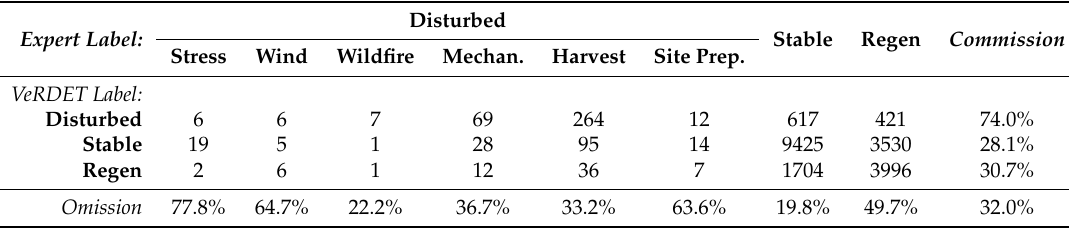
Table 1. Agreement between the VeRDET segmentation and the expert segmentation on whether in each year a sampled location was being disturbed, stable, or regenerated. Experts distinguished between different types of disturbance events.